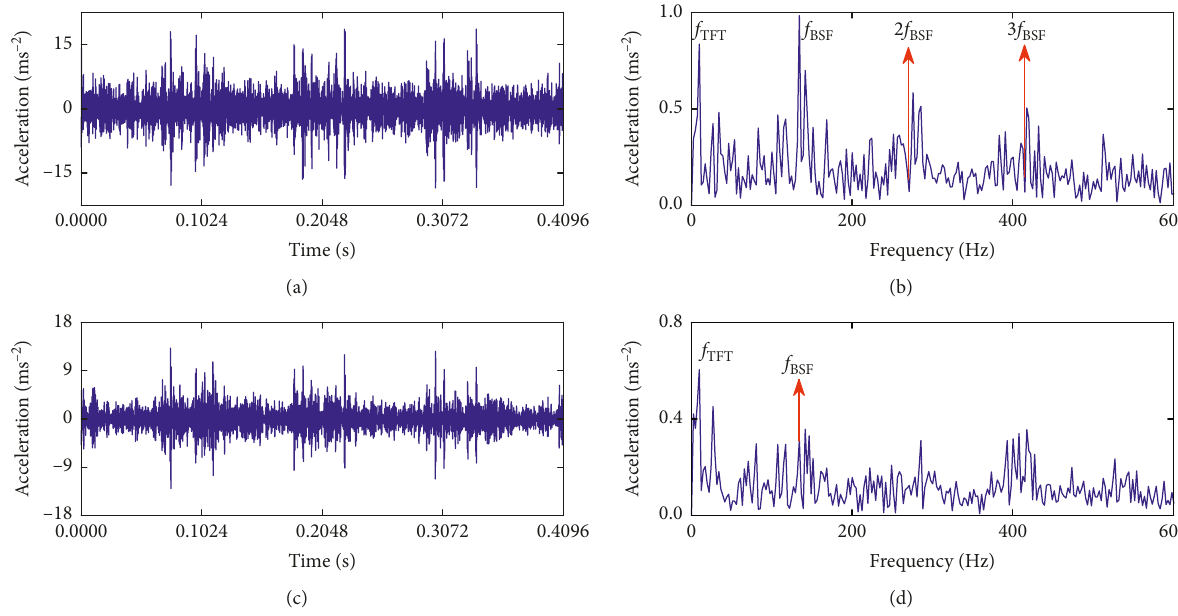
Figure 40: Results obtained using EEMD: (a) IMF1; (b) envelope spectra of IMF1; (c) IMF3; (d) envelope spectra of